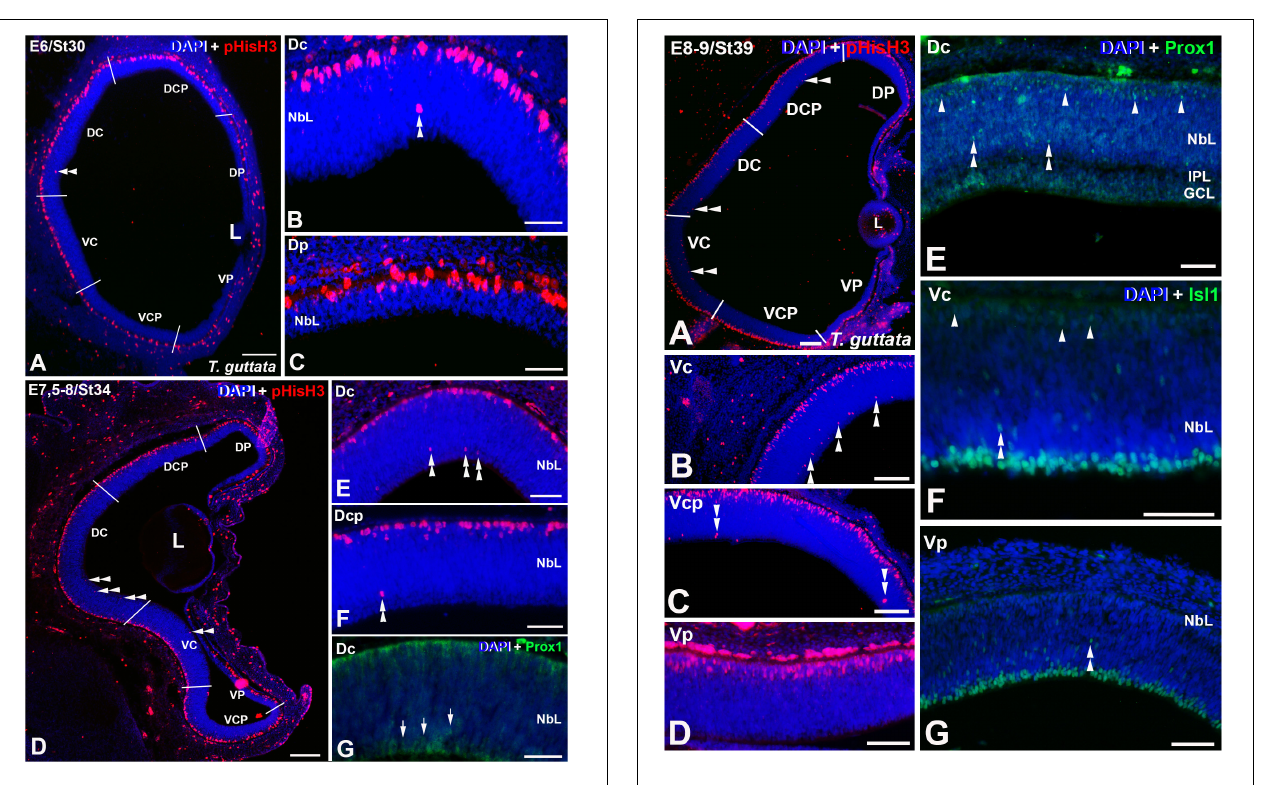
development in T. guttata (see Álvarez-Hernán et al.,